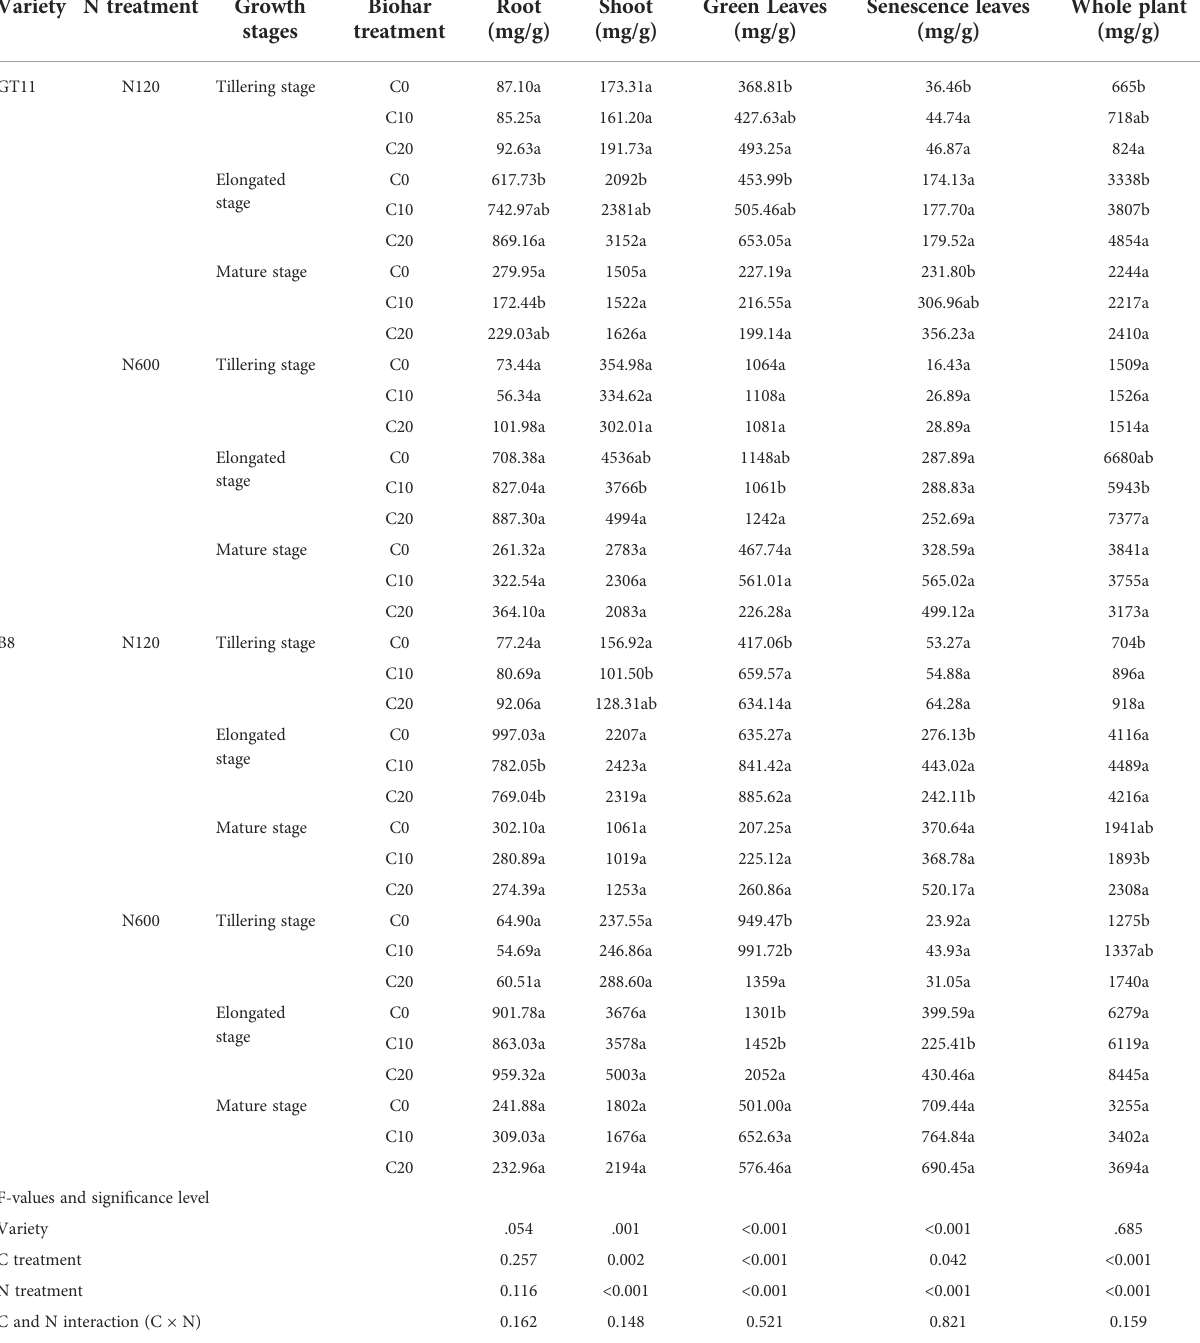
TABLE 2 Effects of biochar and N fertilizer application on N uptake of two sugarcane varieties. Variety N